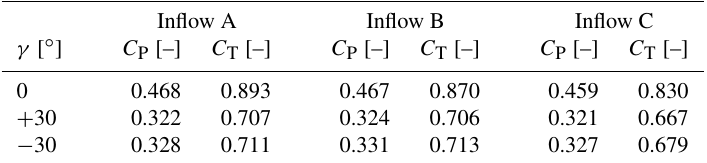
Figure 3. Operating conditions of the model wind turbine: (a) power coefficient C P and (b) thrust coefficient C T for different turbine yaw angels and inflow conditions. The white points indicate the operational conditions under which wake measurements are performed. Cyan-colored points indicate a theoretical power and thrust reduction by yawing of C P ,γ = 0 · cos 3 (30 ◦ ) and C T ,γ = 0 · cos 2 (30 ◦ ), respectively. Table 2. Turbine performance ( C P and C T ) at the optimal operating point ( λ = 6 . 0) for different yaw angles and inflow